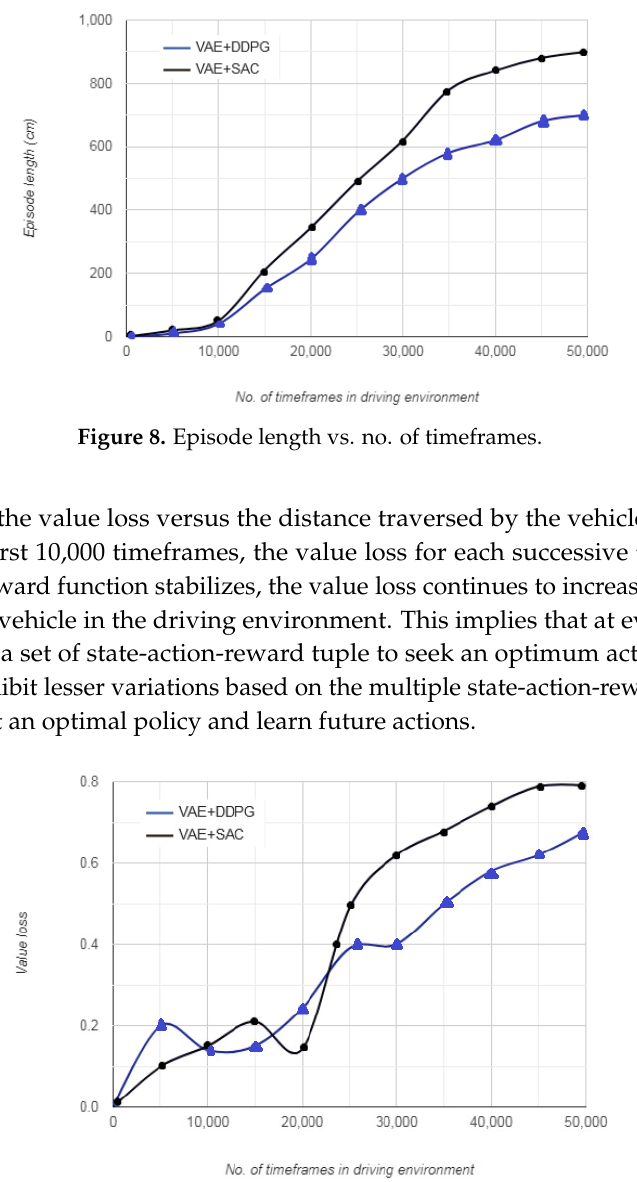
Figure 9. Value loss vs. no. of